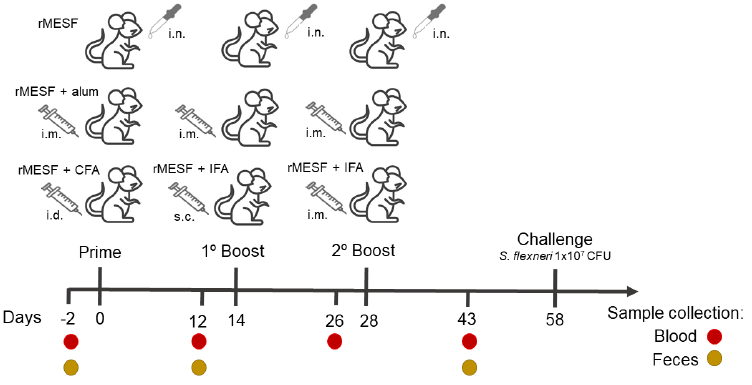
Figure 1. Immunization strategy and sample collection. Days of vaccine administration, adjuvants and routes are shown. The challenge assay was developed 30 days after the last immunization. Blood and feces collection are represented in red and golden brown circles, respectively. For more details of control groups read the text. rMESF, recombinant multiepitope S. flexneri protein. CFA, complete